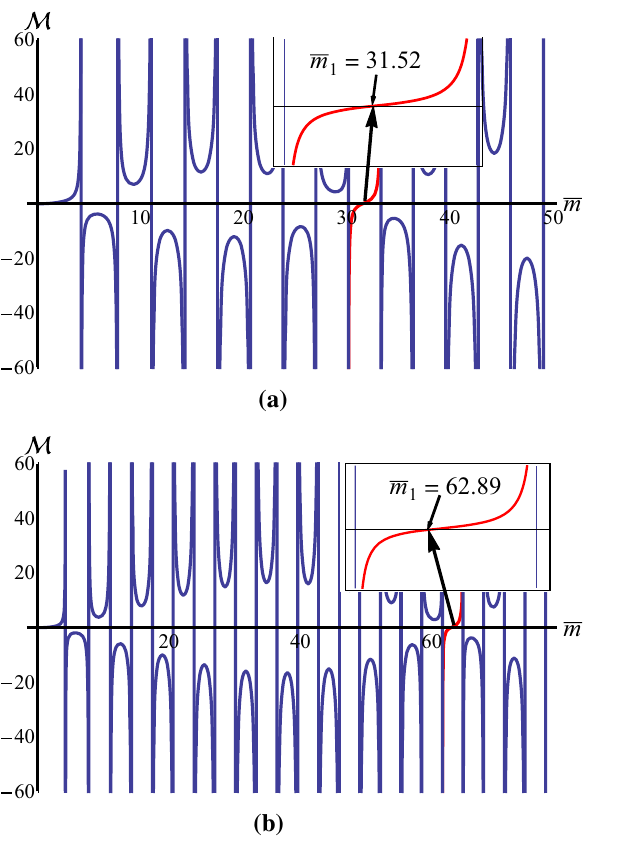
Fig. 3 The effect of the size of the extra dimension, ¯ z b (small ¯ z b < 1), on the mass spectra of the scalar KK modes. The other parameters are set to k = − 3, λ = 5 Fig. 4 The mass spectra of the scalar KK modes. The parameter k is